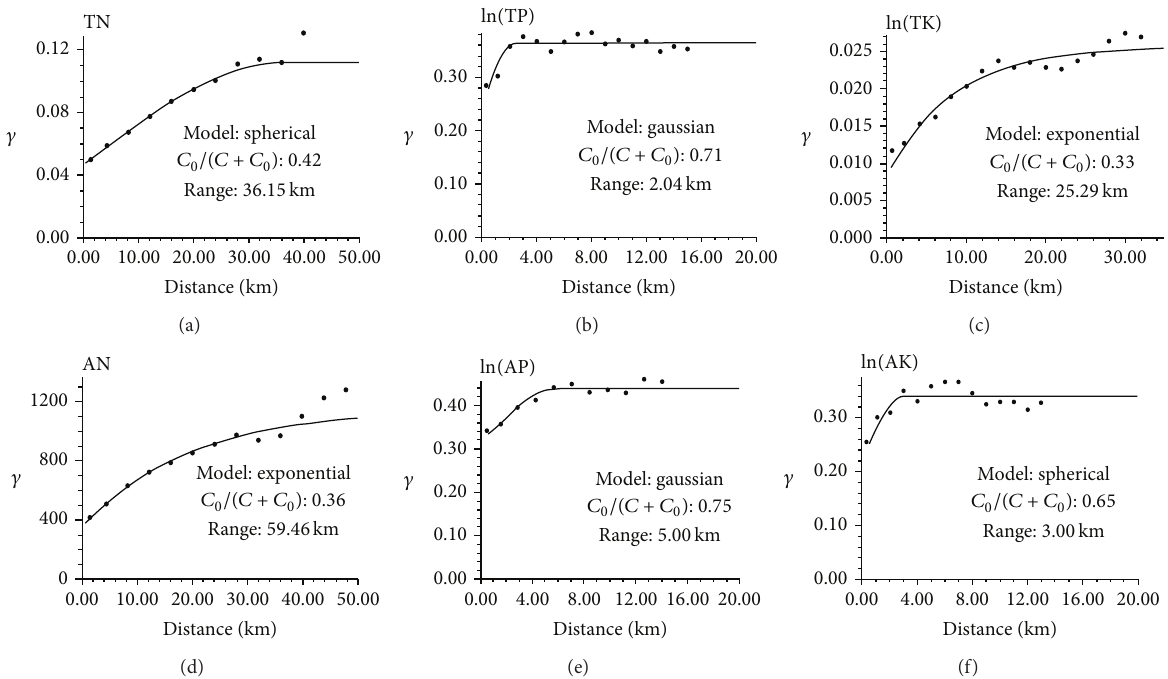
Figure 3: Experimental variograms of TN (a), ln ( TP ) (b), ln ( TK ) (c), AN (d), ln ( AP ) (e), and ln ( AK ) (f), and their fitted